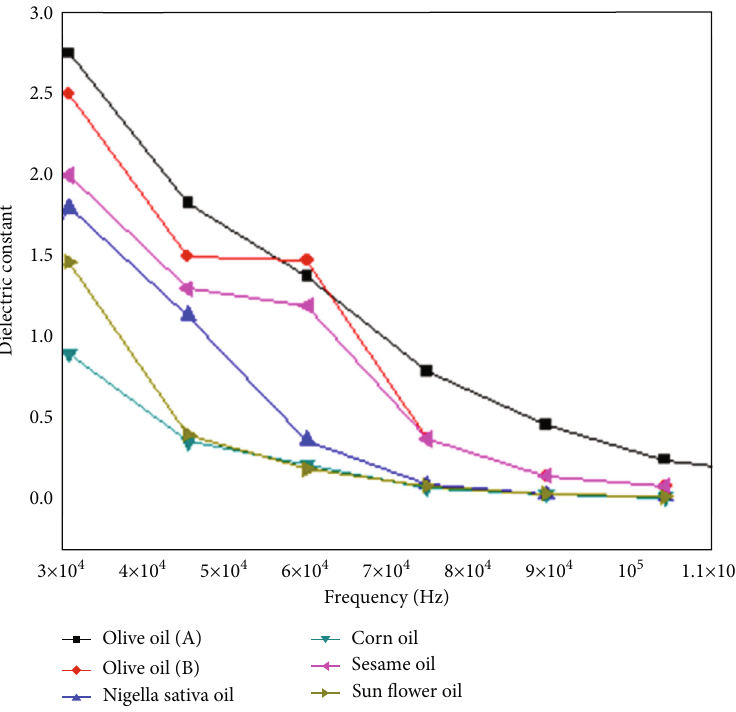
Figure 5: Frequency dependence of the dielectric constant for all samples.